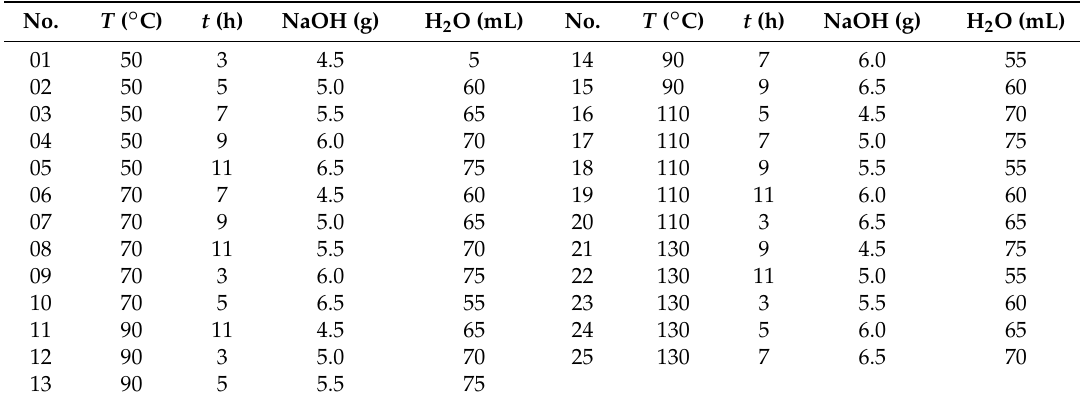
Table 2. The orthogonal array of the 4A zeolite